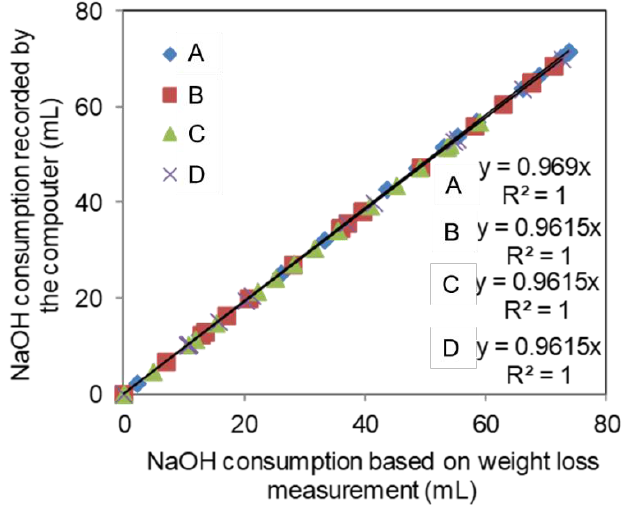
Figure 6. Relationship between the NaOH consumption measured by weight loss and the computer program in the pyrite oxidation experiment with reactors A, B, C, and D. The NaOH consumption determined by weight loss measurement was converted to volumetric consumption using the density of the 1 M NaOH solution (i.e., 1.04 g mL − 1 ). The computer recorded data was obtained by multiplying the flow rate of the NaOH dosing pump (mL s − 1 ) with the cumulative switch on time (s) of the pump.